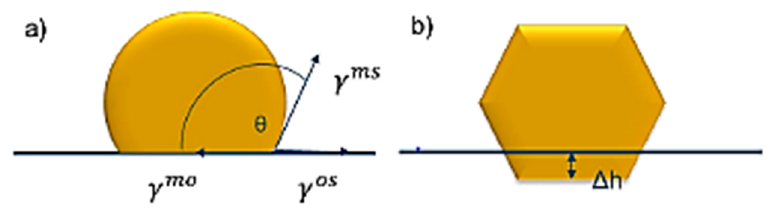
Figure 1. Schematic representation of an equilibrium cluster ( a ) Isotropic surface, γ ms and γ os are metal and oxide surface energy, and γ mo is the interfacial energy between the metal and oxide; ( b ) anisotropic surface and faceted shape (Wulff construction); the cluster is truncated into oxide ( ∆ h ), which is dependent on the cluster surface energy and adhesion energy; Reproduced with permission from [16], World Scientific, 2001.